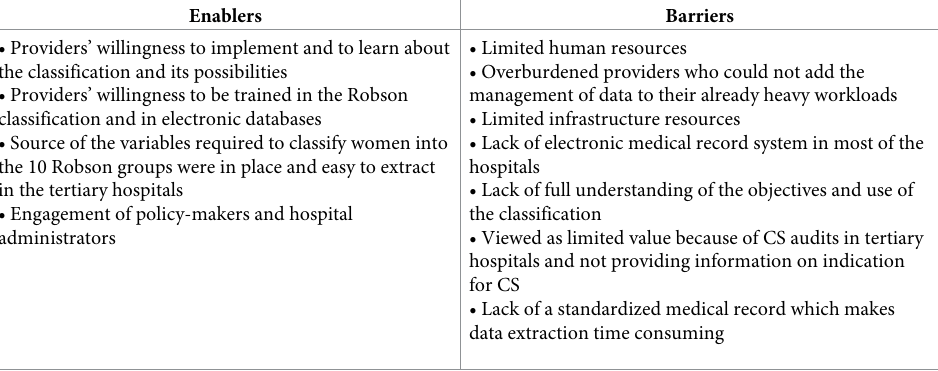
Table 2. Barriers and enablers to implement Robson classification system in public hospitals in Myanmar.